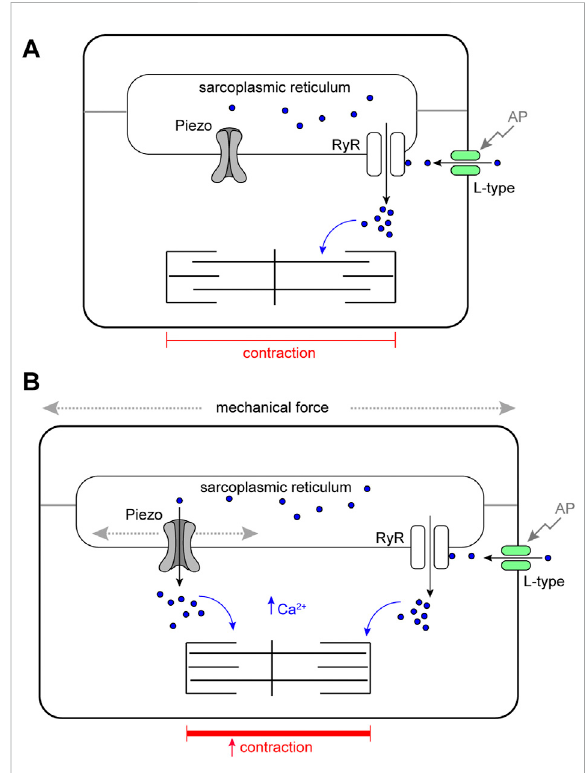
FIGURE 6 Schematic model of Piezo in the Drosophila cardiomyocyte. (A) Cardiomyocyte contraction is controlled by cytoplasmic Ca 2+ . Depolarisation of the membrane by an action potential (AP) opens sarcolemmal L-type voltage-gated Ca 2+ channels activating further Ca 2+ release from the sarcoplasmic reticulum (SR) through Ryanodine Receptors (RyR). Cytoplasmic Ca 2+ activates the myo fi laments and leads to contraction of the cell. In circumstances where mechanical force is within normal range, SR localised Piezo channels are closed. (B) In circumstances where mechanical force (e.g. stretch or compression). exceeds the normal range SR, localised Piezo channels open, additional Ca 2+ is released from the SR elevating the cytoplasmic Ca 2+ pool, this leads to a stronger